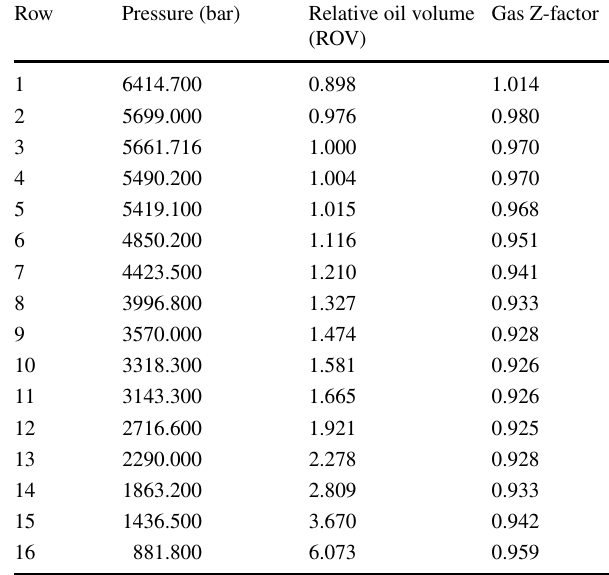
Table 2 Results of CCE test on the reservoir fluid sample